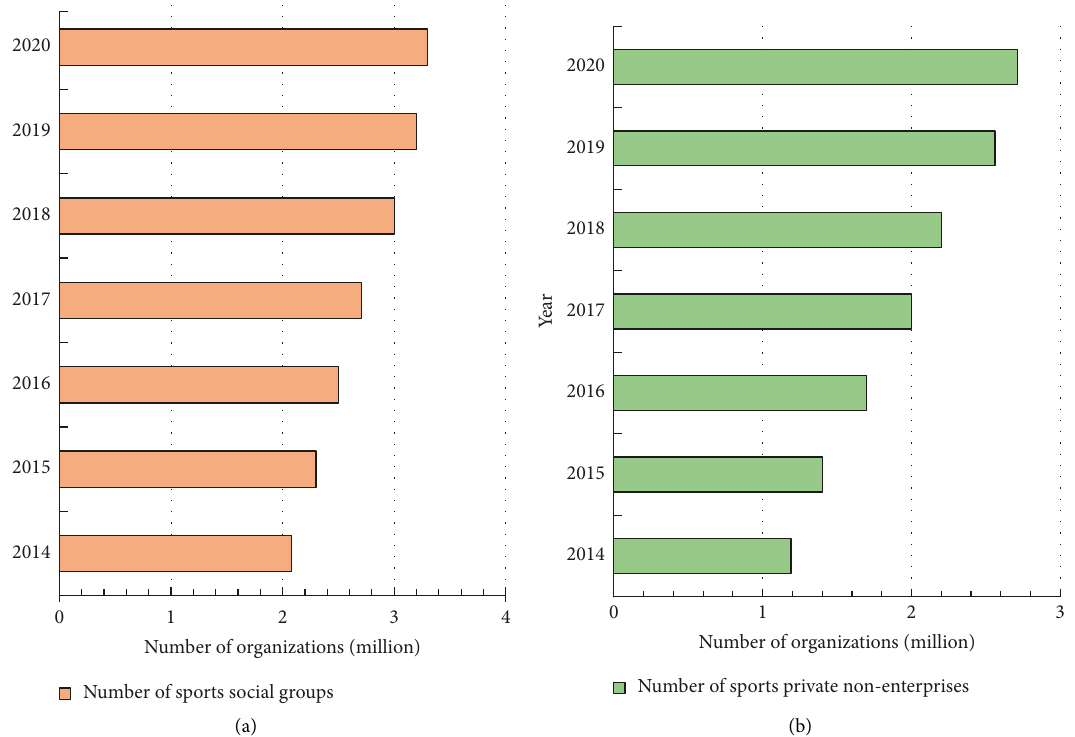
Figure 9: Statistics on the number of sports organizations in China from 2014 to